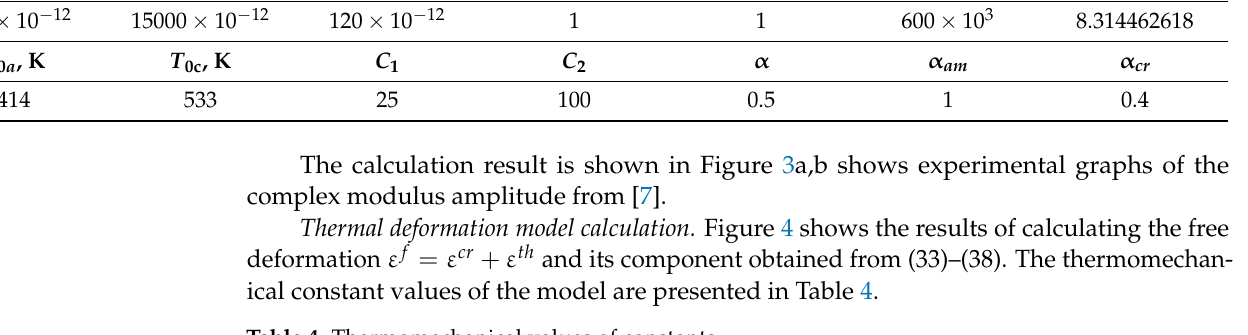
Table 3. Values of constants for calculating the dependence of a complex modulus.